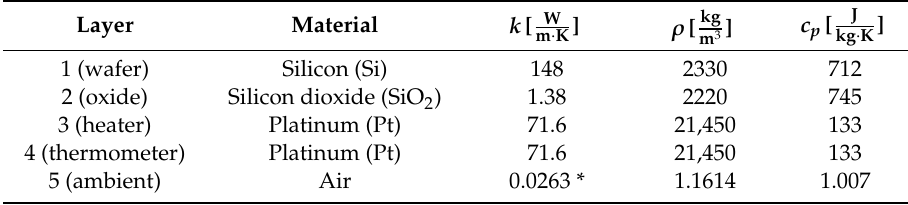
Table 2. Considered material parameters’ values